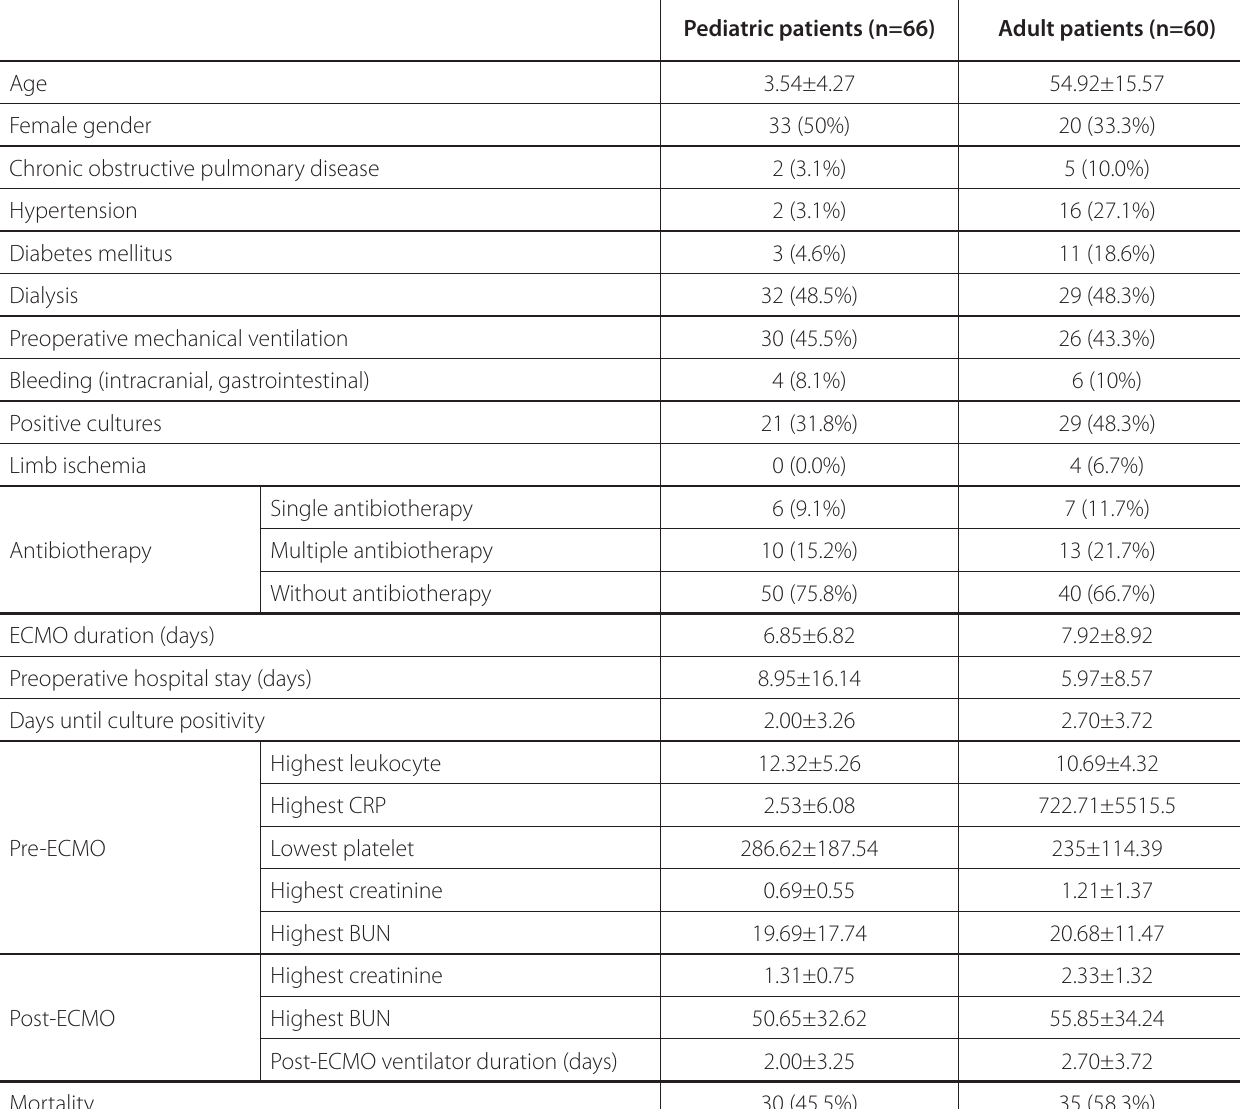
Table 1 . Demographic characteristics of ECMO